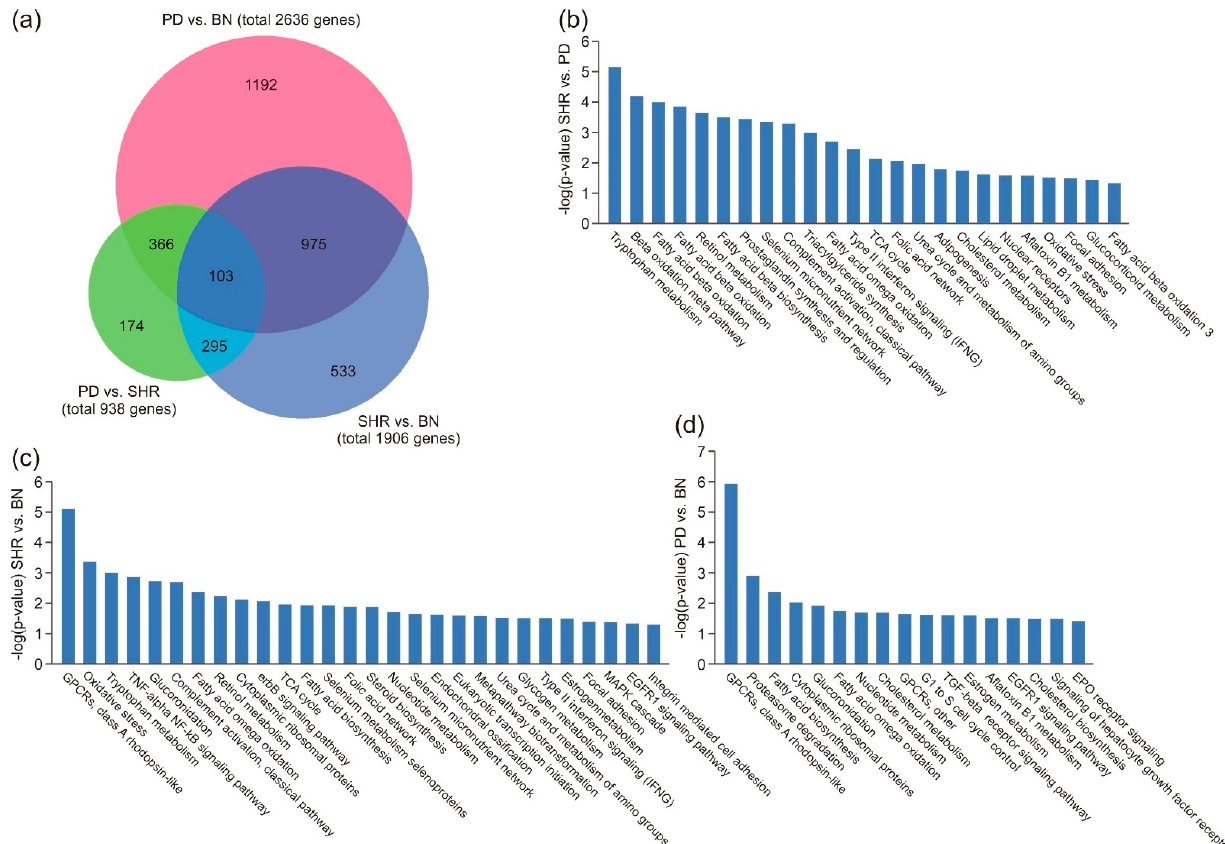
Figure 3 . Differentially expressed genes in the liver after HFD. Venn diagram ( a ), pathway enrichment analysis using Transcriptomic analysis console software ( b – d ). ( b ) Pathway enrichment analysis-SHR vs. PD comparison. ( c ) Pathway enrichment analysis—SHR vs. BN comparison. ( d ) Pathway enrichment analysis − PD vs. BN comparison.